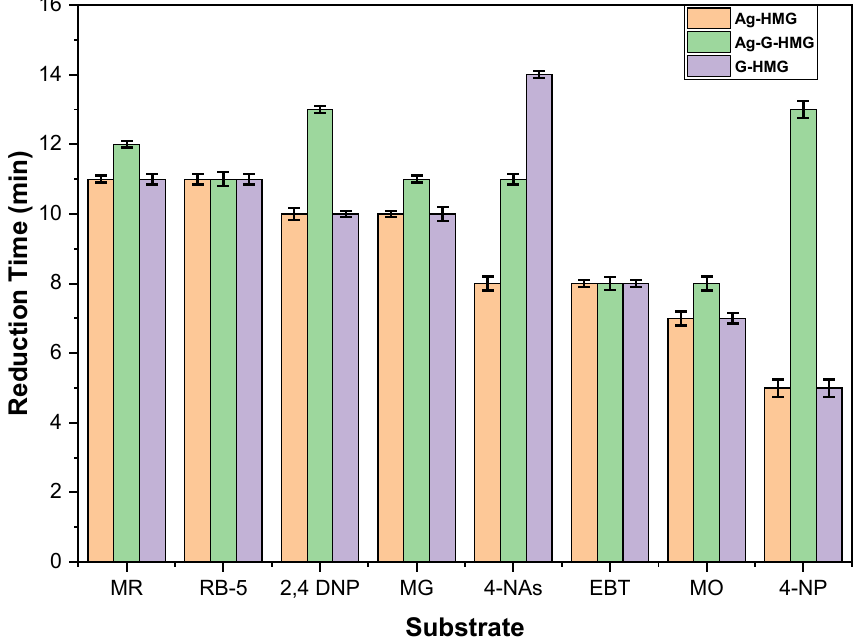
Figure 4. A plot of comparisons of the reduction times of different substrates reduced through the use of different hybrid microgels as catalysts.